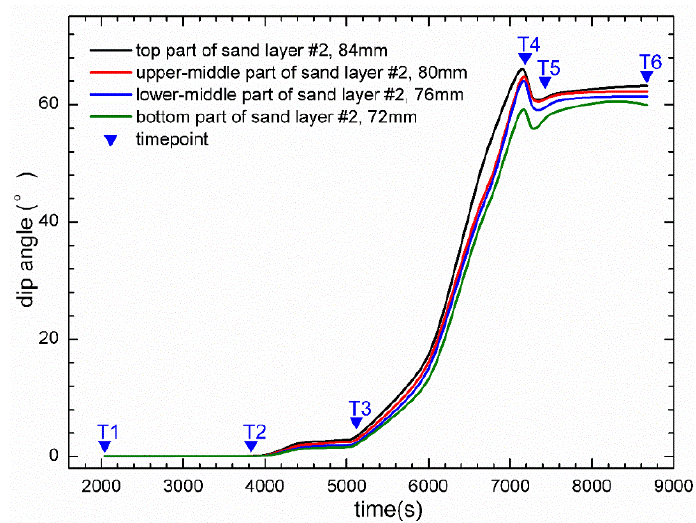
Figure 10. The dip angle of the normal fault over time. The data from Figure 6d, between 85 mm and 110 mm in the x-coordinate and 70 mm and 90 mm in the y-coordinate.